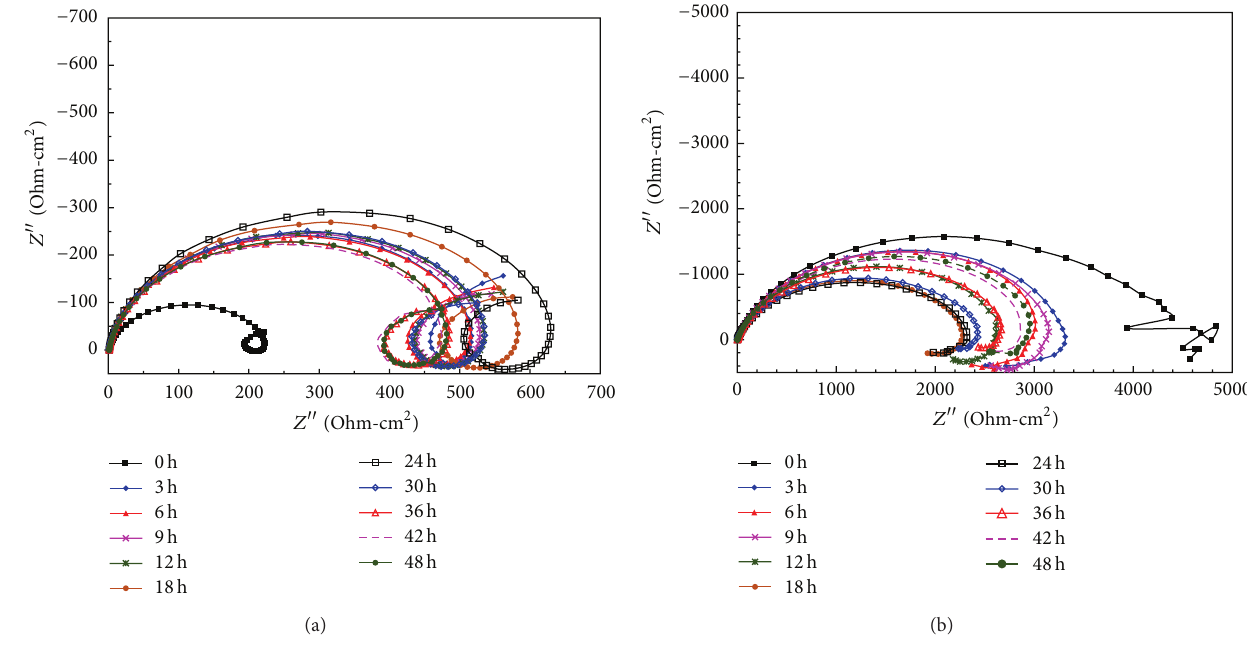
Figure 15: Examples of Nyquist plots for (a) Al; (b) Ni 3